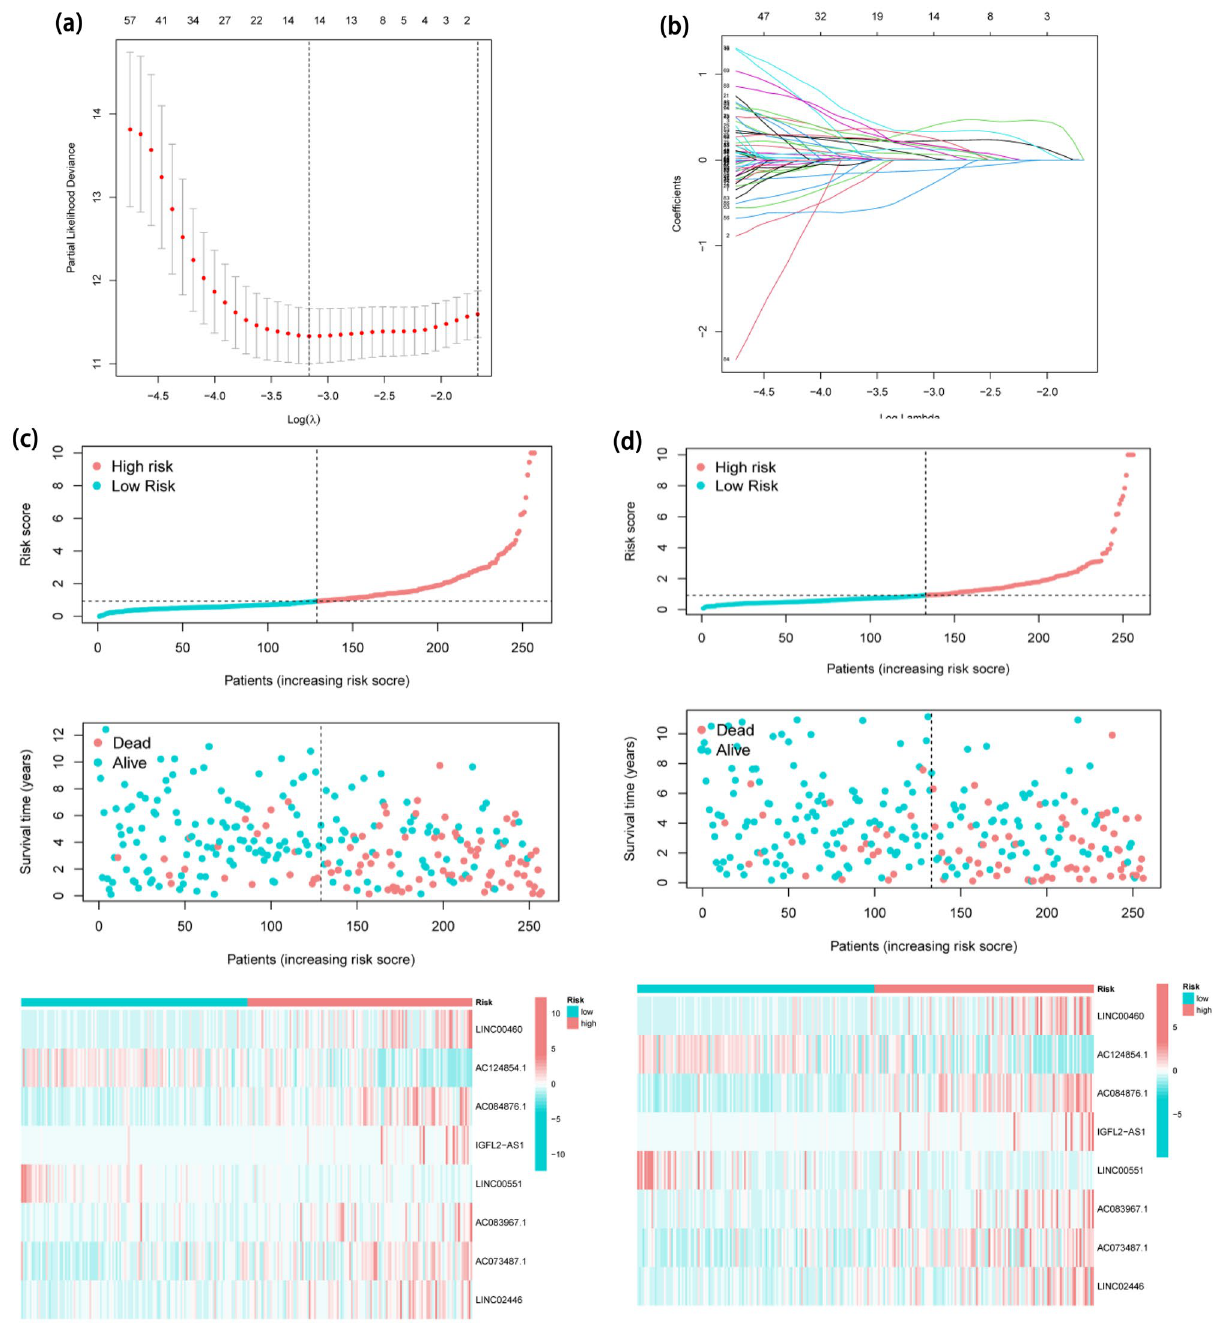
Figure 3. Establishment and verification of FLPS. ( a ) The vertical black line in the figure denotes the ideal log λ value. ( b ) In the LASSO coefficient profile of FALs, each line denotes a distinct lncRNA. ( c ) The risk score, survival status, and heatmap in experimental set. ( d ) The risk score, survival status, and heatmap in validation set. ( e ) KM curves for survival probability in experimental cohort (P < 0.001). ( f ) KM curves for survival probability in validation cohort (P < 0.001). ( g ) The AUC values for prediction of survival rates of ccRCC at 1, 3, and 5